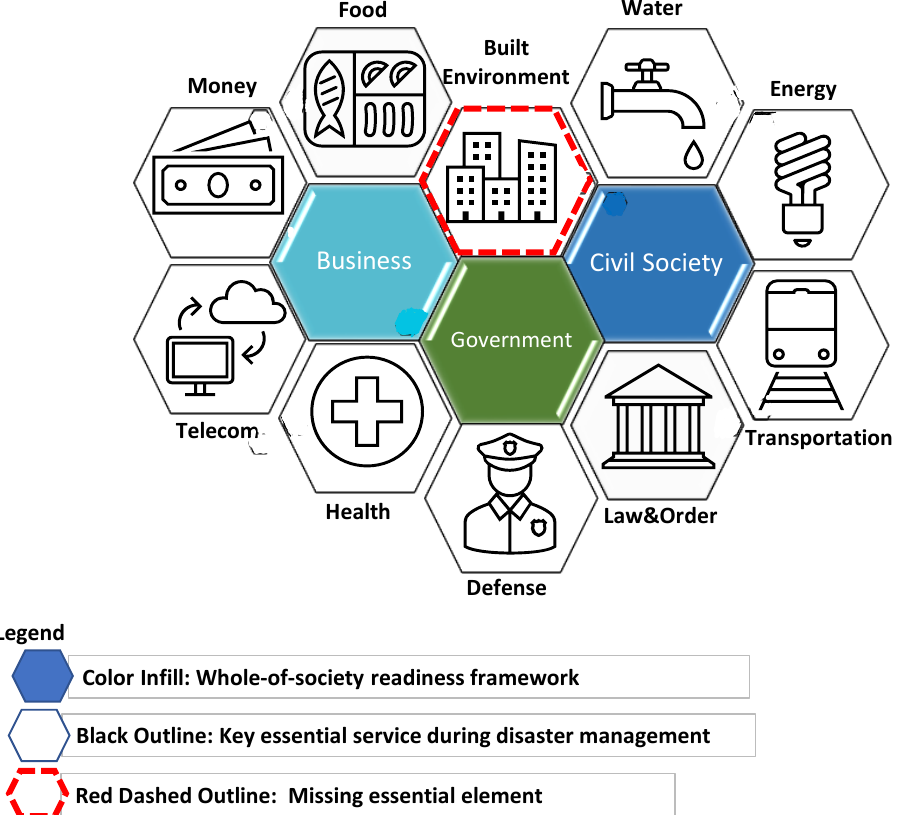
Figure 2. Whole-of-Society response inclusive of the built environment [12,14,18].